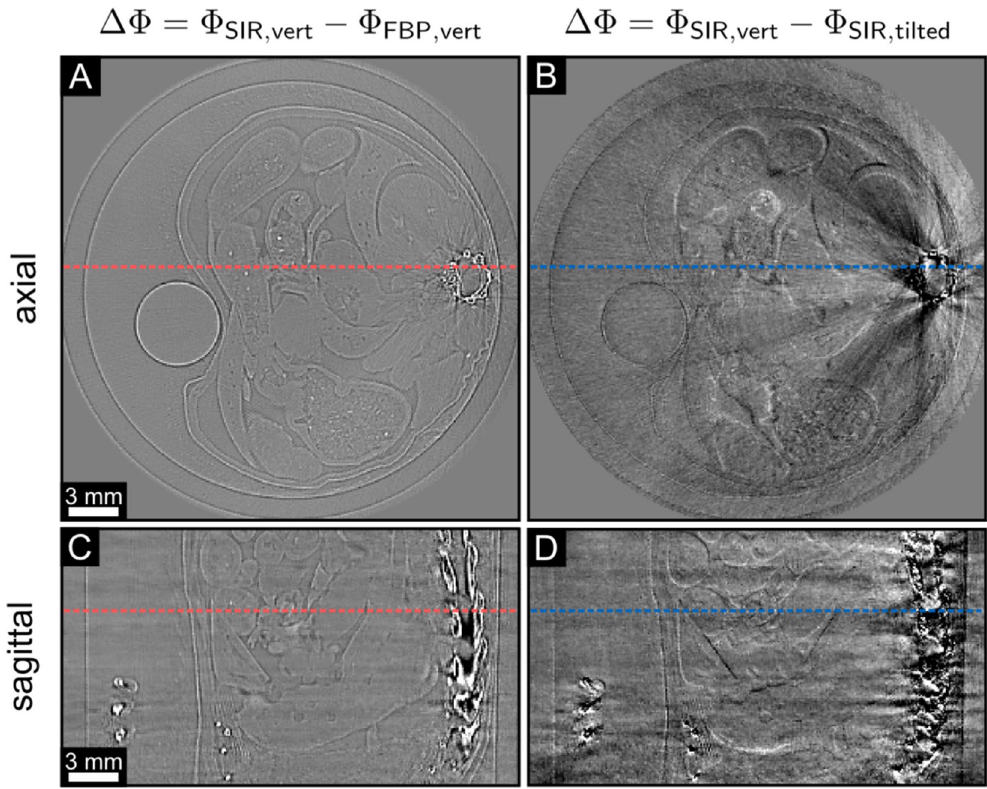
Figure 5. Difference images between different phase-contrast tomograms. The left column shows the differences between the FBP and the SIR algorithm with vertical gratings in axial ( A ) and sagittal view ( C ). The right column shows the differences of the phase-contrast tomograms of the vertical and the tilted grating configuration with SIR, both in axial ( B ) and sagittal view ( D ). The slices are the same as depicted in Fig. 4. The arrows with asterisk represent the same area of the slices shown in Fig. 4. The dashed lines indicate the corresponding axial or sagittal slice. All phase-contrast values Φ are ranged in a linear scale of [ − 0.01,